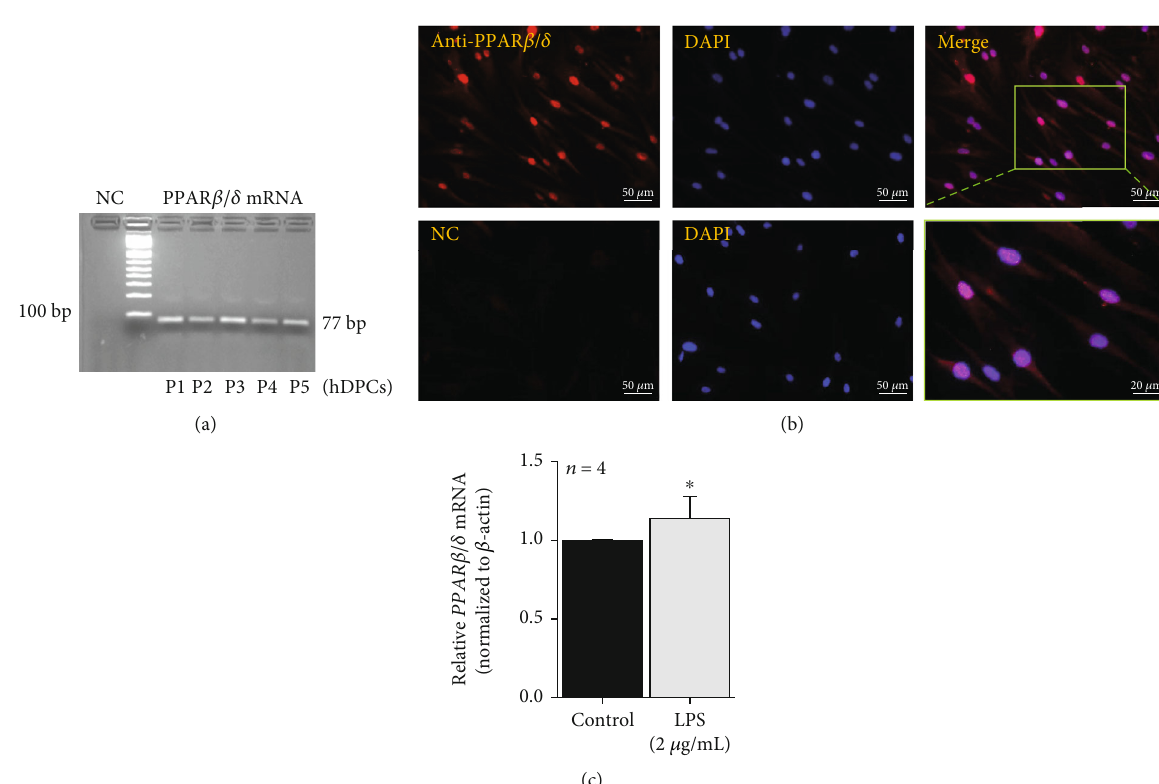
Figure 1: Human dental pulp cells express PPAR β / δ : (a) PPAR β / δ mRNA was ubiquitously expressed in all fi ve hDPC cultures; (b) representative immuno fl uorescence labeling of hDPCs stained with anti-PPAR β / δ antibody (red) and nucleus (blue/DAPI). Merged images demonstrated that PPAR β / δ was widely immunolocalized in the nuclei. NC: negative control, without primary anti-PPAR β / δ antibody. (c) Treatment with 2 μ g/mL LPS increased PPAR β / δ mRNA level ( ∗ p < 0 : 05 vs. control by Mann-Whitney test; mean ± S : E : M : n = per group ). Control = DMSO 0 : 1 %